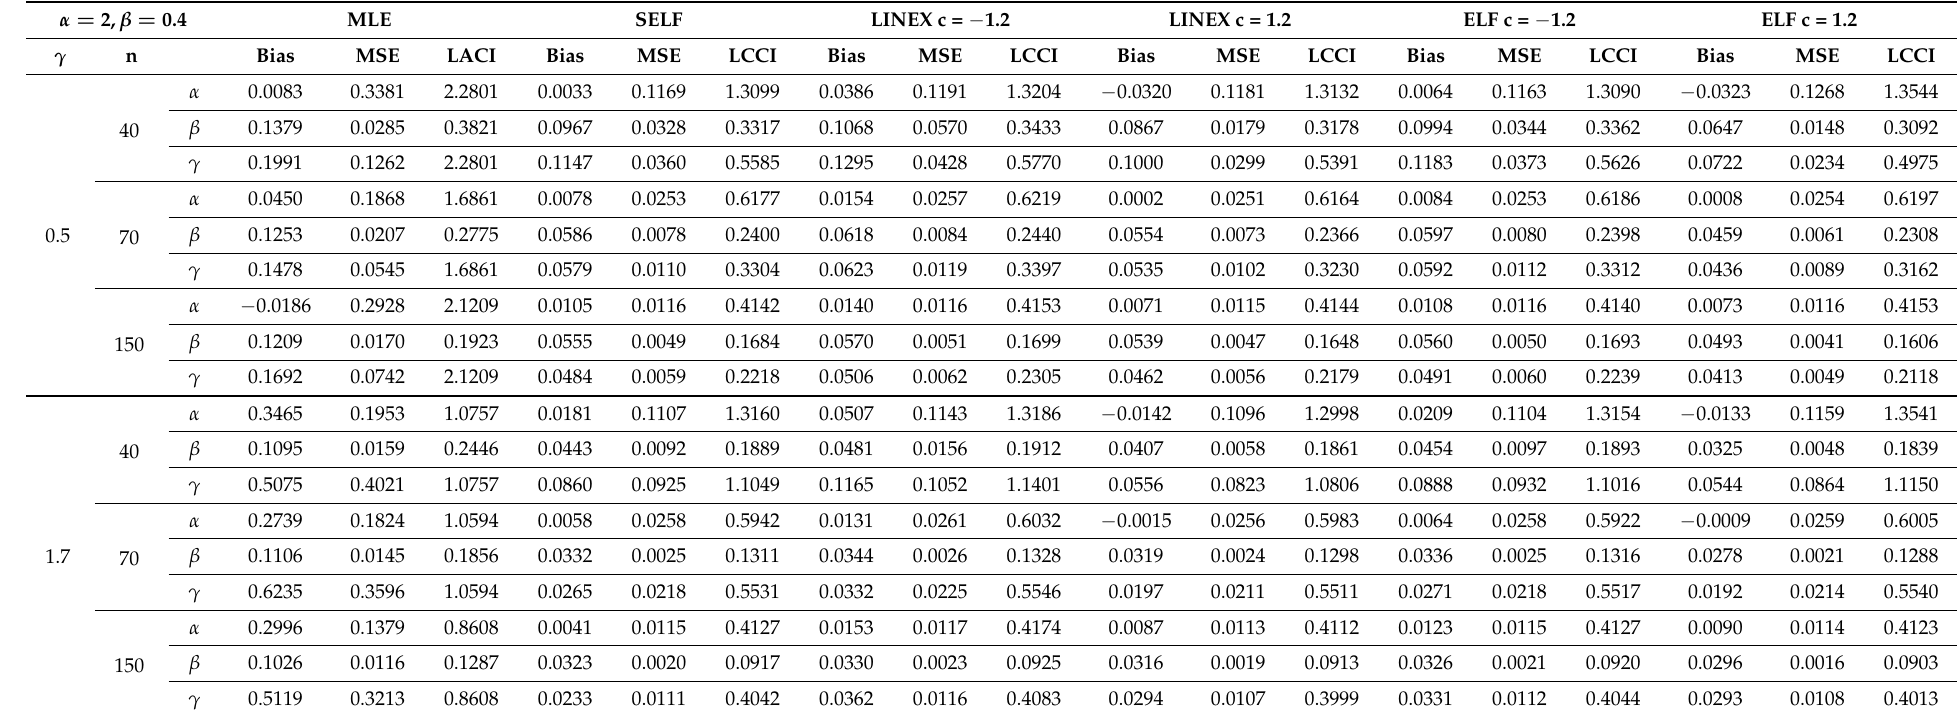
Table 6. Bias, MSE and LCI for MLE and Bayesian estimation methods for α = 2, β =